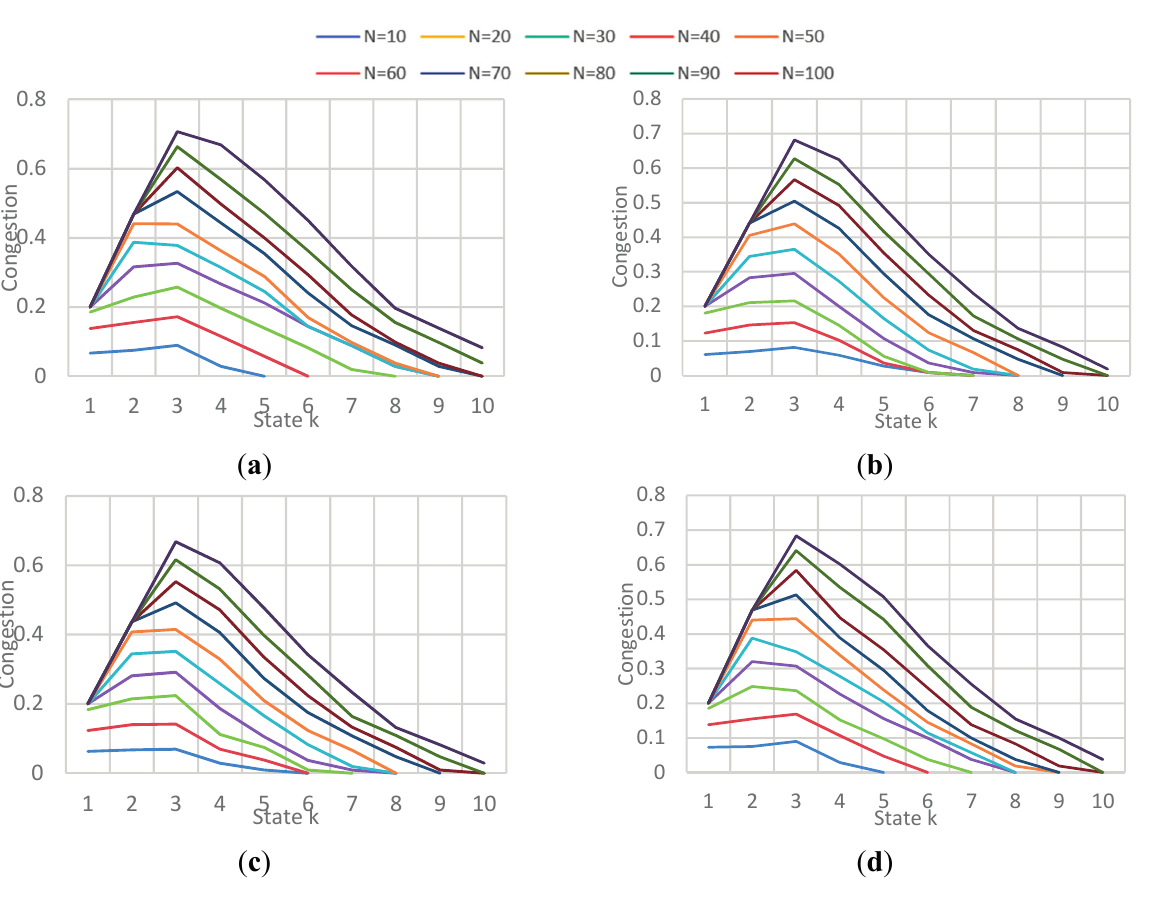
Figure 23. Obtained Average Congestion in a state k for each N-vehicle set with each implementation. ( a ) Avg. Congestion obtained for each N-vehicles with Natural behavior algorithm; ( b ) Avg. Congestion for each N-vehicles with Local congestion algorithm; ( c ) Avg. Congestion for each N-vehicles with Global Congestion algorithm; ( d ) Avg. Congestion for each N-vehicles with Modified Dijkstra